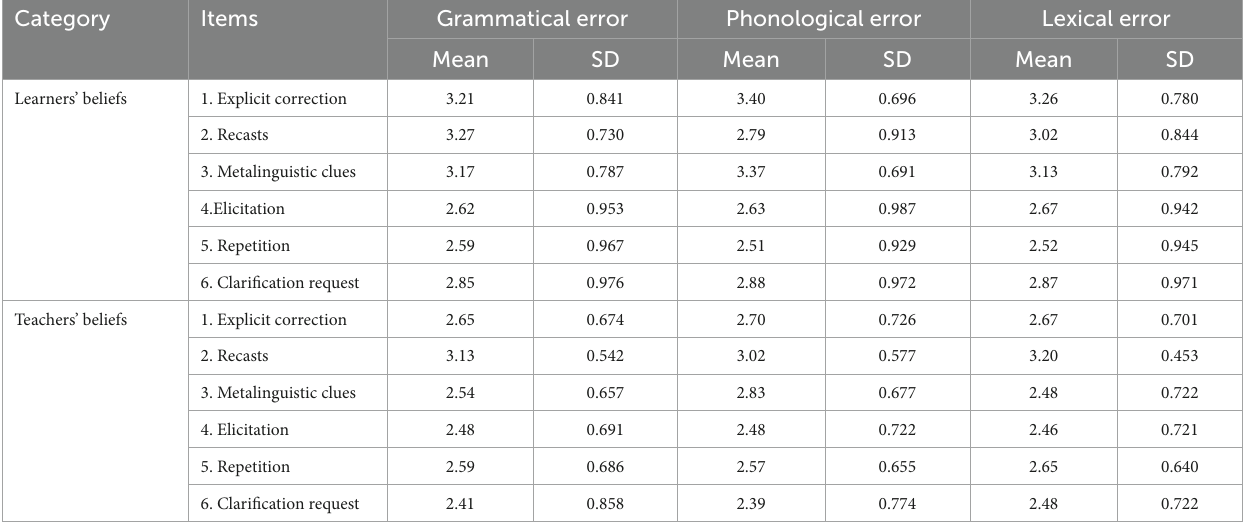
TABLE 3 Teachers’ and students’ preferences for different types of CF